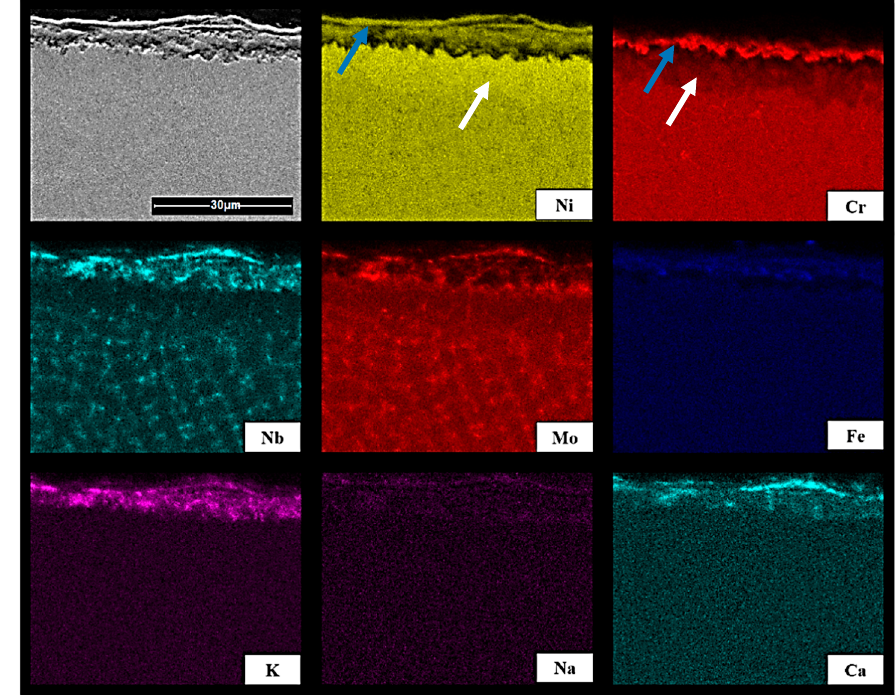
Figure 4. The SEM–EDX map of element distribution of Inconel 625 after exposure to mixed wood biomass ash